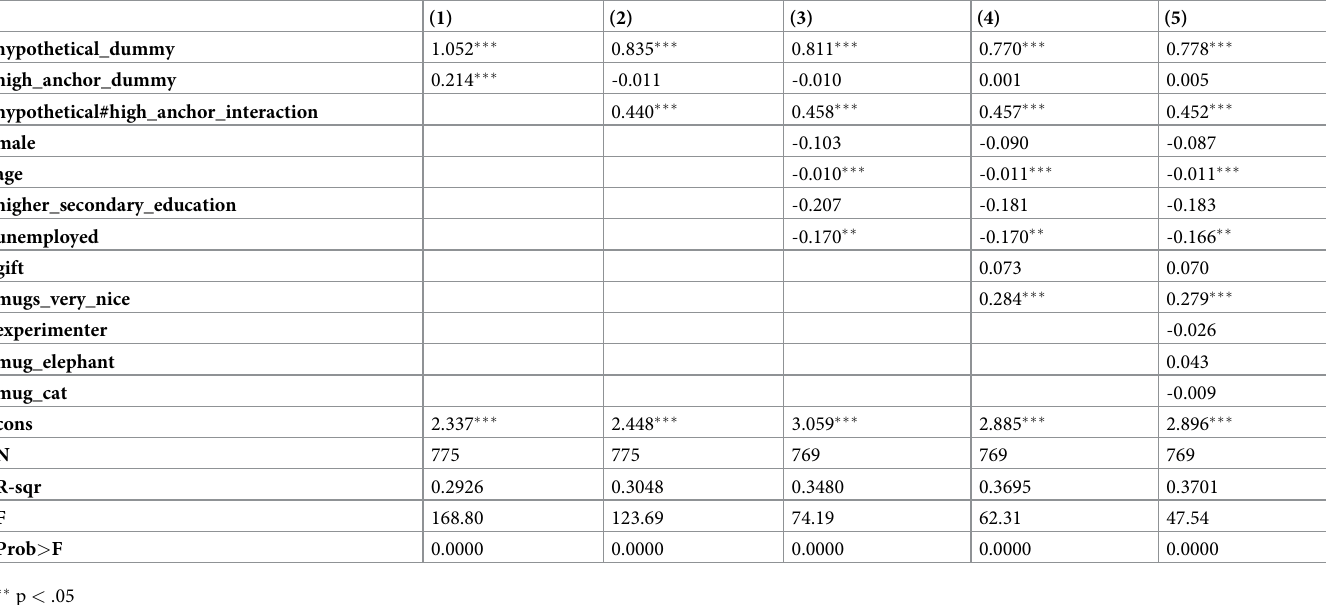
Table 9. Experiment 2: Regression table: WTP